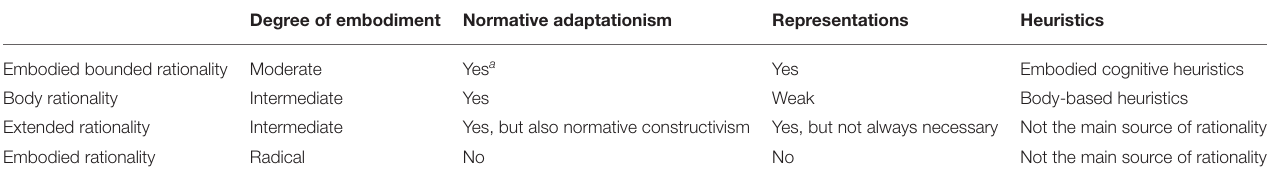
TABLE 1 | Main features of the embodied approaches to